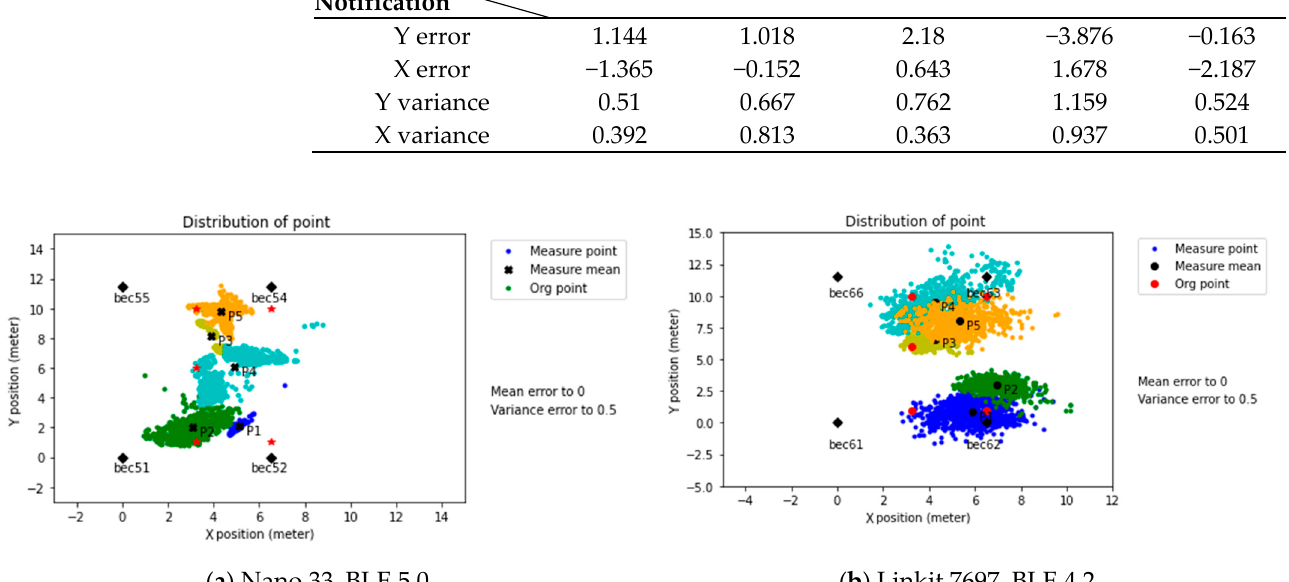
Figure 15. Common setup and predicted positioning.